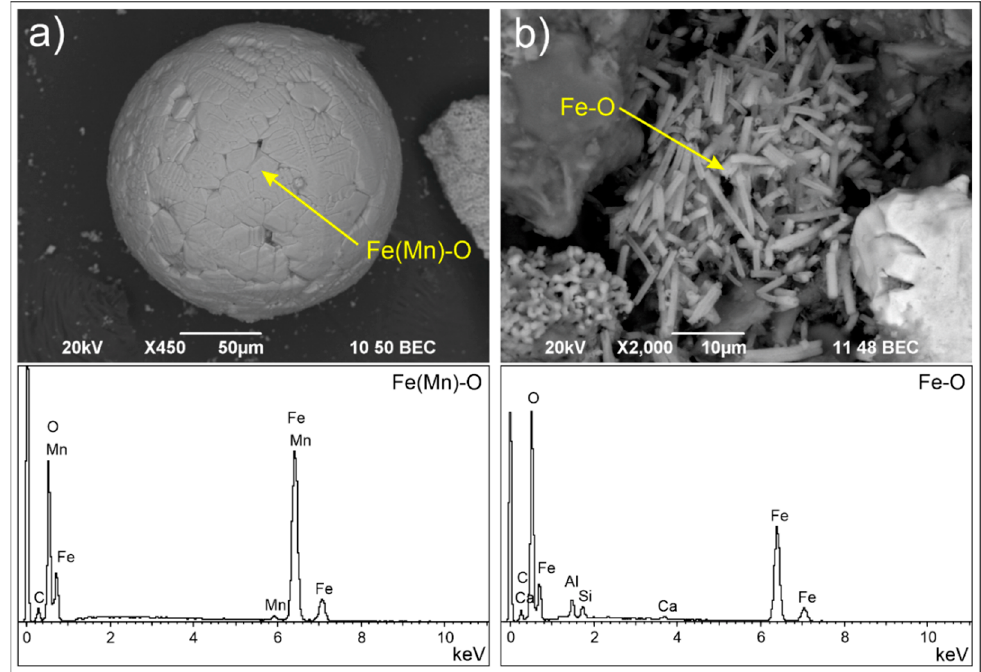
Figure 6. SEM(BSE) images and EDS spectra of solid Fe carriers in stream sediment: ( a ) Fe(Mn)-oxide spherule with a dendritic surface; ( b ) Fe-oxide/oxyhydroxide tubes.